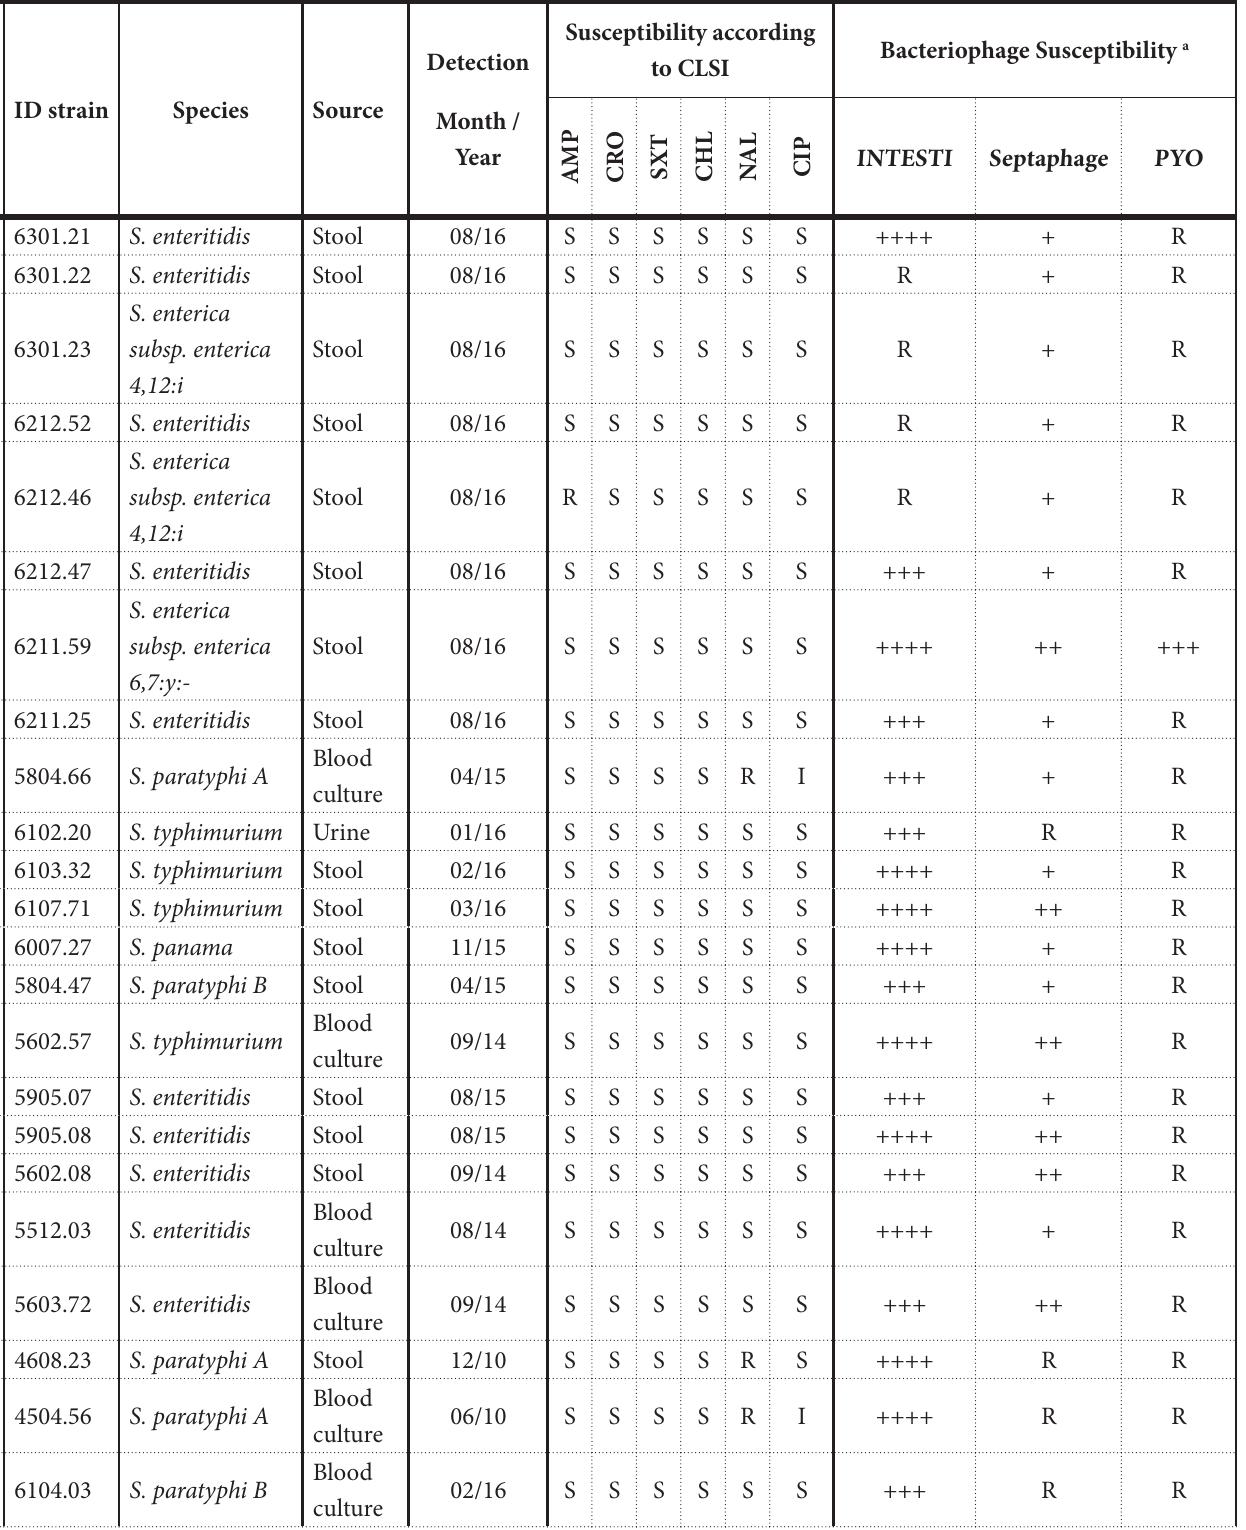
Supplementary Table 1. Characteristics of the 30 Salmonella and 20 Shigella spp. strains and susceptibility to 3 commercial bacteriophage cocktails